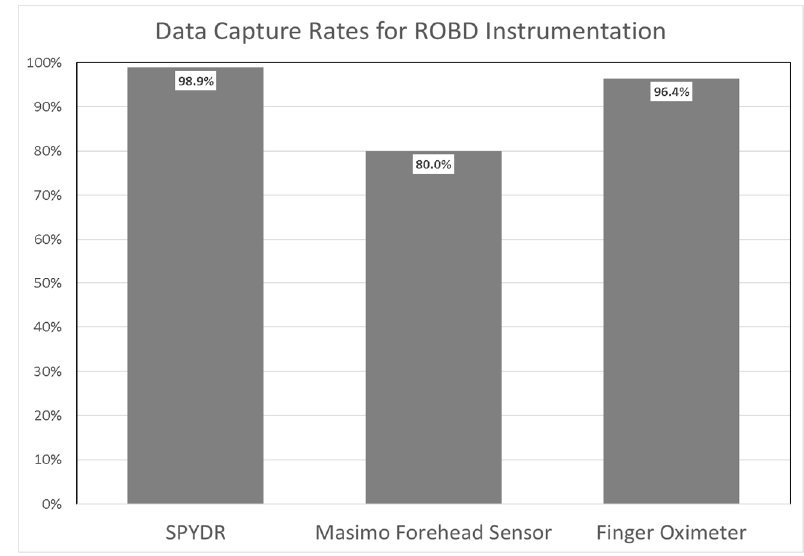
Figure 8. Data capture rates for SPYDR, Forehead, and Finger sensors used to monitor pulse rate and blood oxygenation (SPO2) during ROBD verification and validation. SPYDR capture rate was 98.9%, Forehead sensor was 80.0%, and Finger sensor was 96.4%.